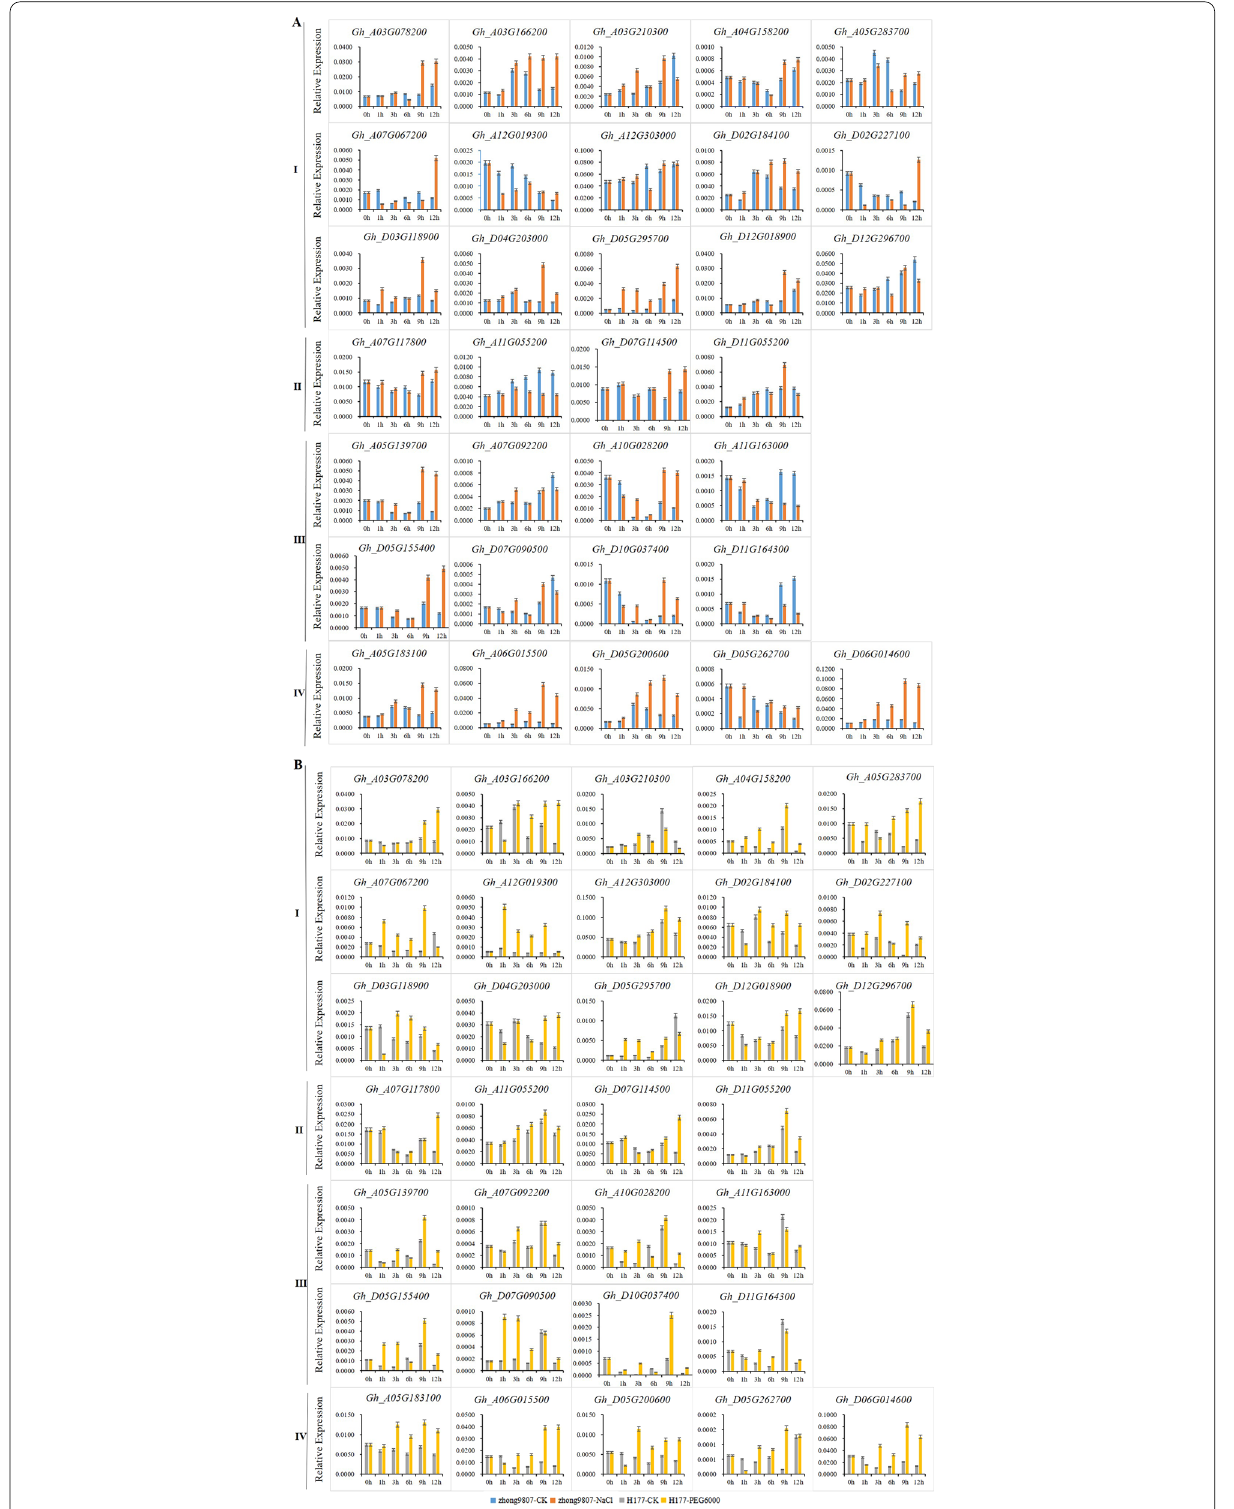
Fig. 7 Expression pattern of GhNAT genes in response to abiotic stresses by qRT-PCR. A The expression level of GhNATs in leaves of Zhong9807 under 0 and 200 mmol L − 1 NaCl treatment. B The expression level of GhNATs in the leaves of H177 under 0 and 12% PEG6000 ·